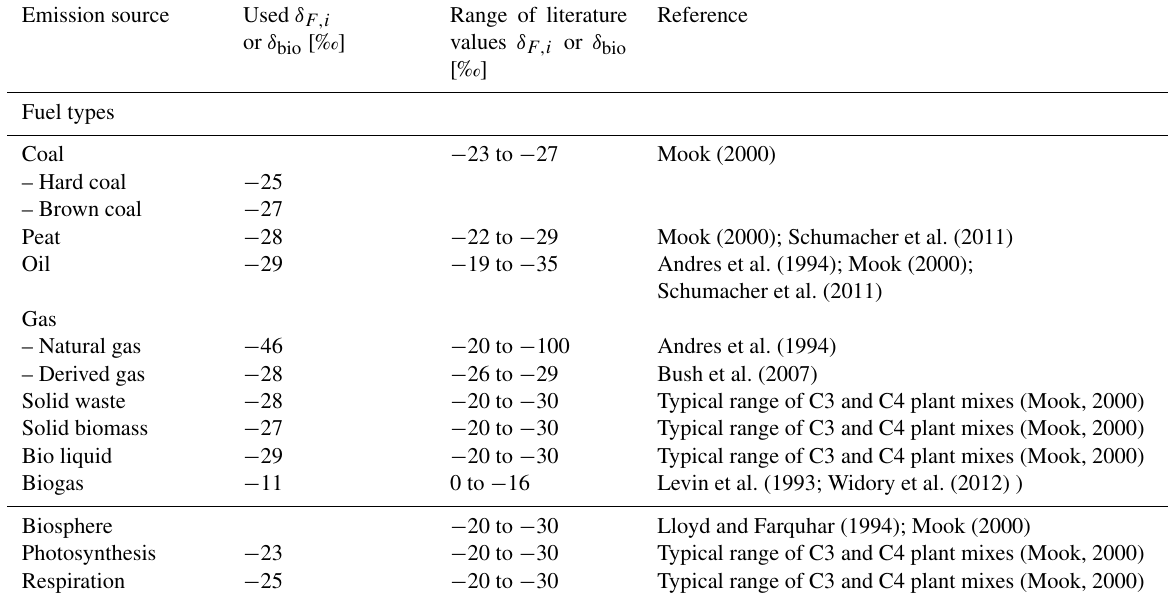
Table A1. δ 13 C(CO 2 ) source signature of fuel types and biosphere as used in the model and the range of literature values. Note that for a specified region the range of possible isotopic signature can often be narrowed down if the origin and/or production process of the fuel type is